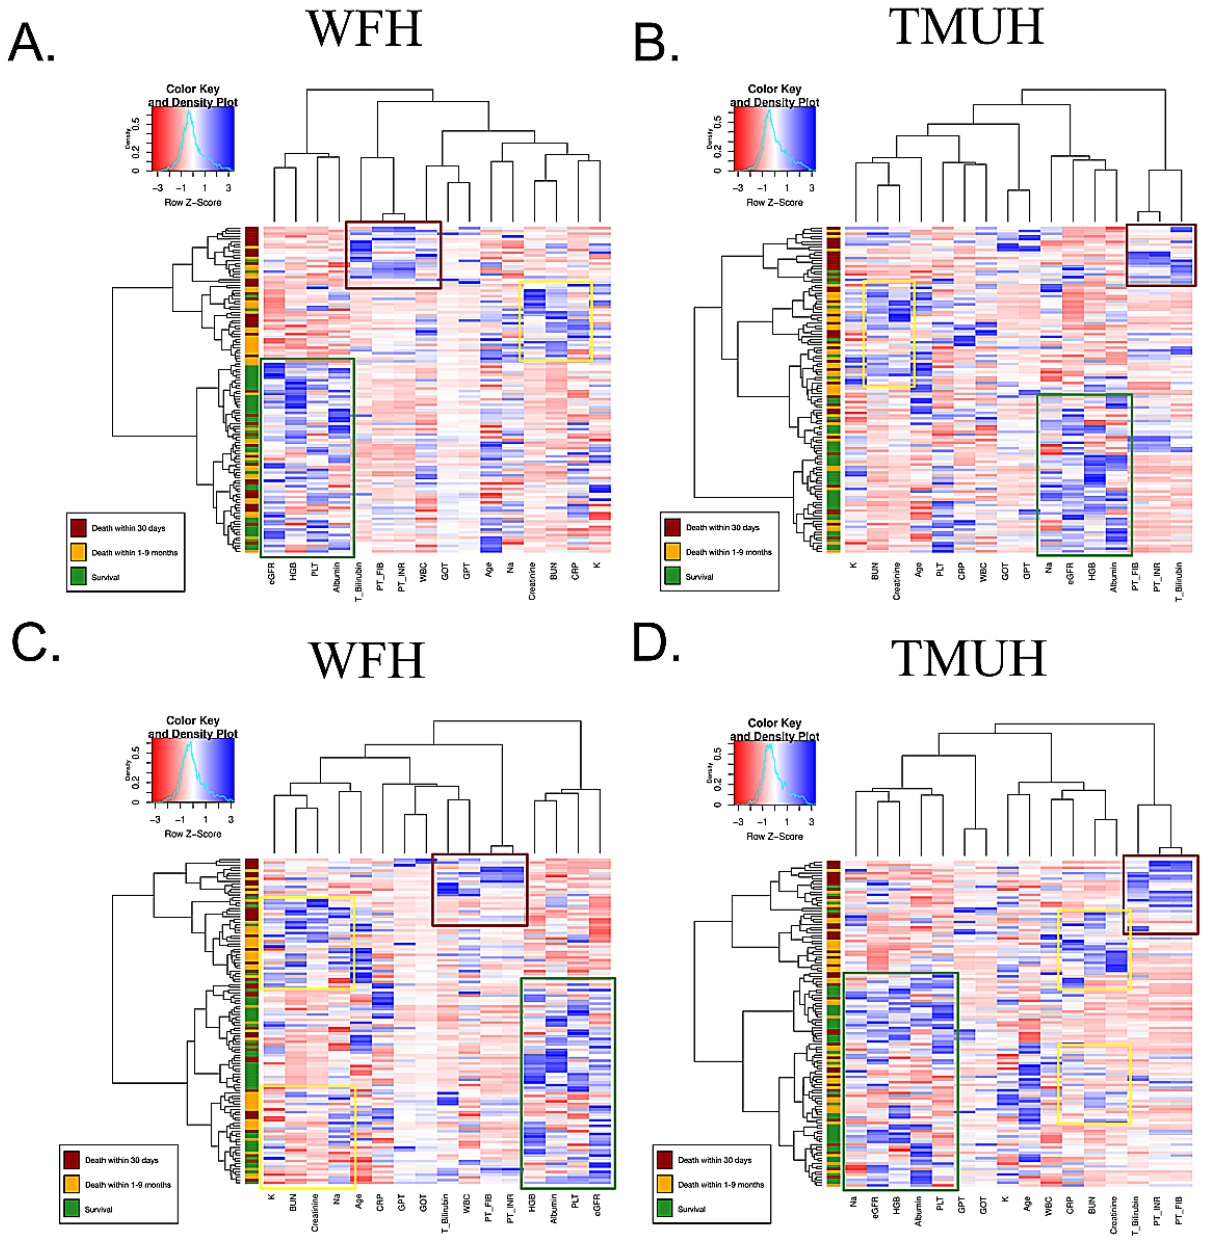
Figure 7. Heatmap showing the classification of acute care (death within 30 days), palliative care (death within 1-9 months), and survival groups in Wan Fang Hospital (WFH) cohort (A and C) and Taipei Medical University Hospital (TMUH) cohort (B and D). BUN: blood urea nitrogen; Bilirubin_T: total bilirubin; CRP: C-reactive protein; eGFR: estimated glomerular filtration rate; GlucoseAC: glucose ante cibum; GOT: serum glutamic-oxaloacetic transaminase; GPT: serum glutamic-pyruvic transaminase; HGB: hemoglobin; K: potassium; Na: sodium; PLT: platelets; PT: prothrombin time; INR: international normalized ratio; WBC: leukocyte